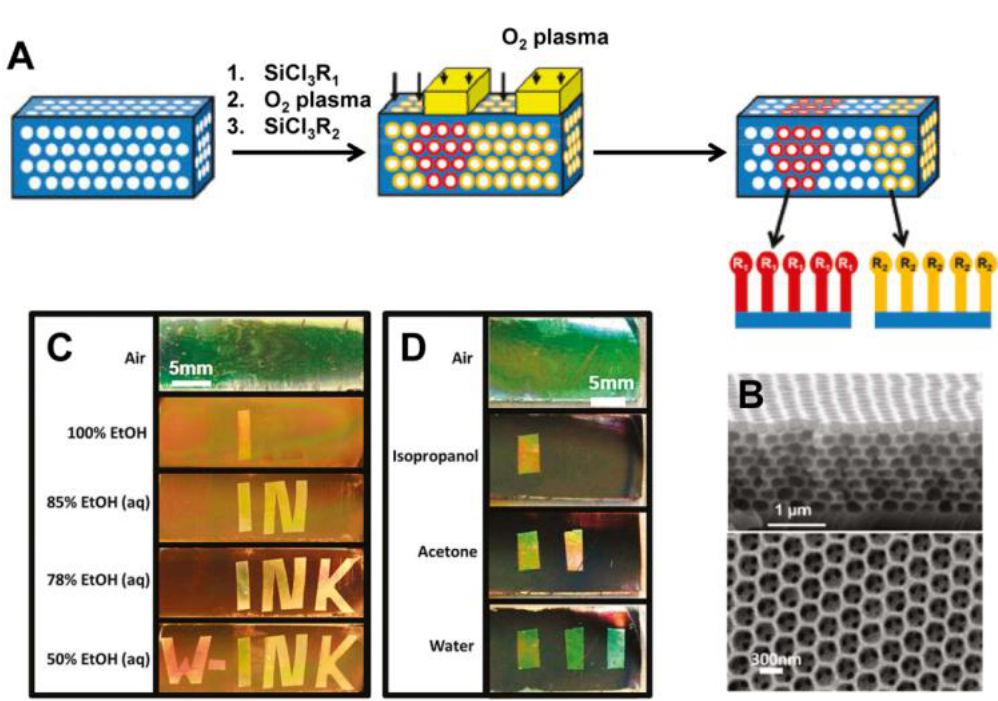
Figure 6. ( A ) Schematic of the chemical encoding procedure. The inner surfaces of IOFs are functionalized by repeated iterations of exposing the entire film to alkylchlorosilane vapors, followed by selective exposure to oxygen plasma. ( B ) SEM micrographs of cross section (top) and top view (bottom) on IOFs ( C ) Optical images of an IOF in which the word “W-INK” is encoded via the surface chemistry in an IOF. In different concentrations of ethanol, different words appear. ( D ) Optical images of a encoded film displaying distinct optical patterns when immersed in different solvents